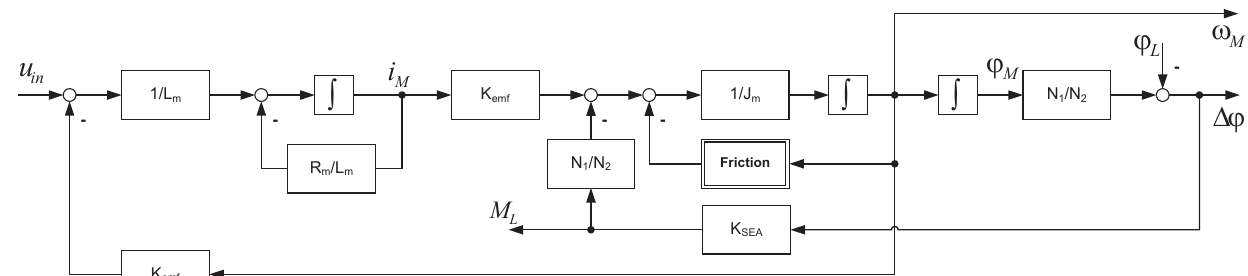
Figure 2. Nonlinear system model of the compliant actuator with the brushless direct-current (BLDC) motor, gearbox reduction and load coupling. Input: u = [ u M ] T y = [ ω M L